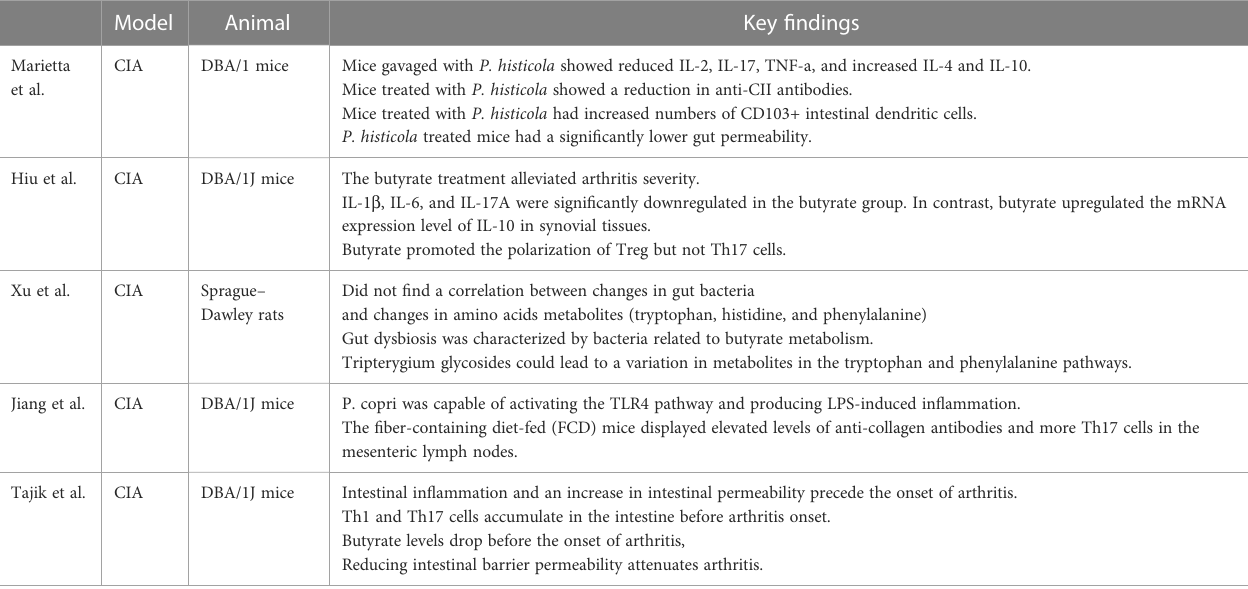
TABLE 2 Summary of possible underlying mechanisms by which intestinal dysbiosis contributes to the development of arthritis in rodents with collagen- induced arthritis. Model Animal Key fi ndings Marietta et